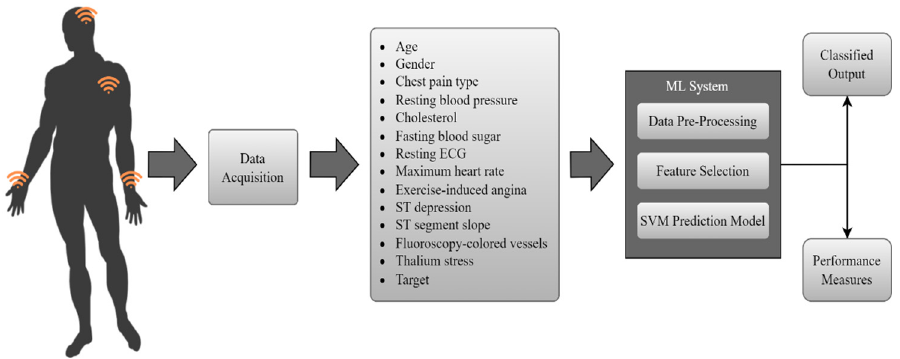
Figure 1. The proposed model’s overall working process.